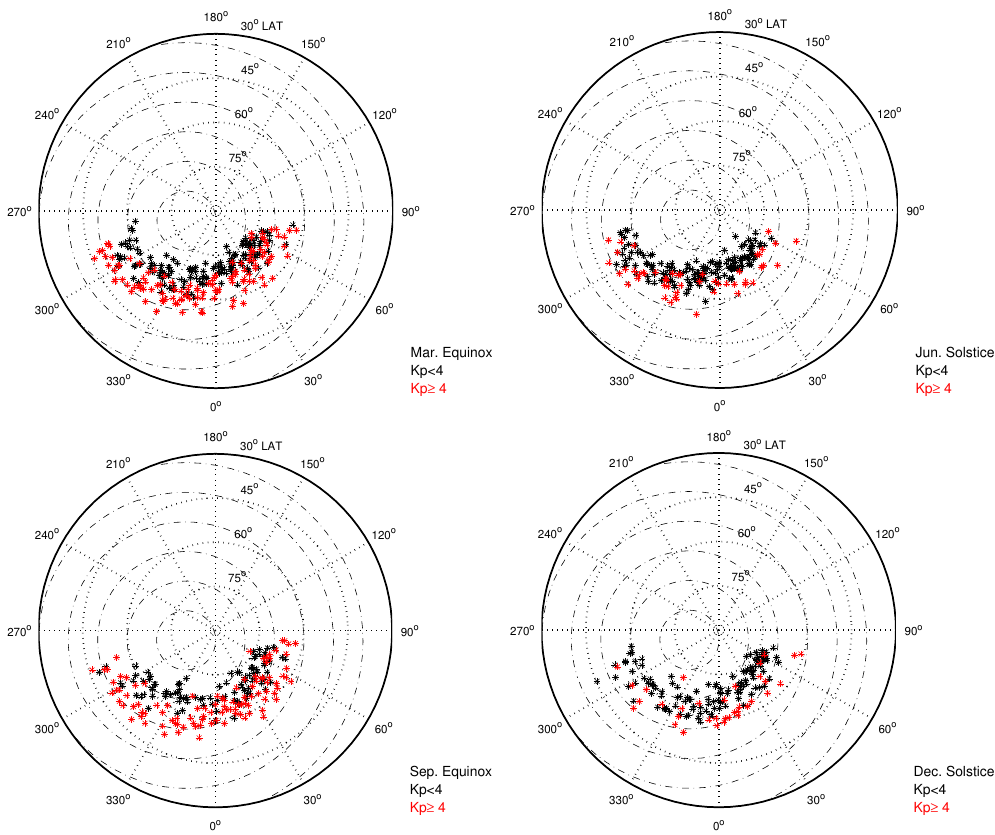
Fig. 1. Locations of DMSP F13 SAPS detections in the geographical latitude and longitude in the Northern Hemisphere for each season and Kp bin. Geomagnetic latitude contours are also shown as dotted-dashed lines at 10 ◦ separately. Table 1. The number of selected DMSP SAPS events and mean Kp value in each season group. The abbreviation “ME” denotes March equinox, “JS” June solstice, “SE” September equinox, “DS” December